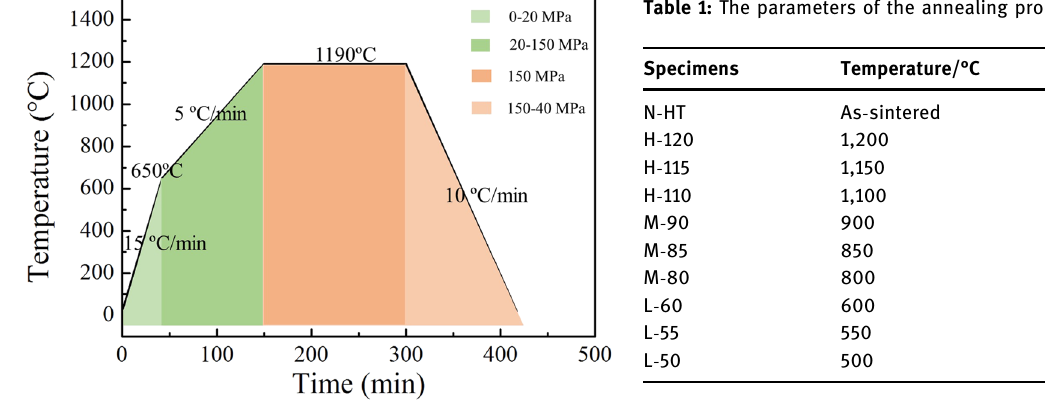
Figure 1: The sintered process curve.